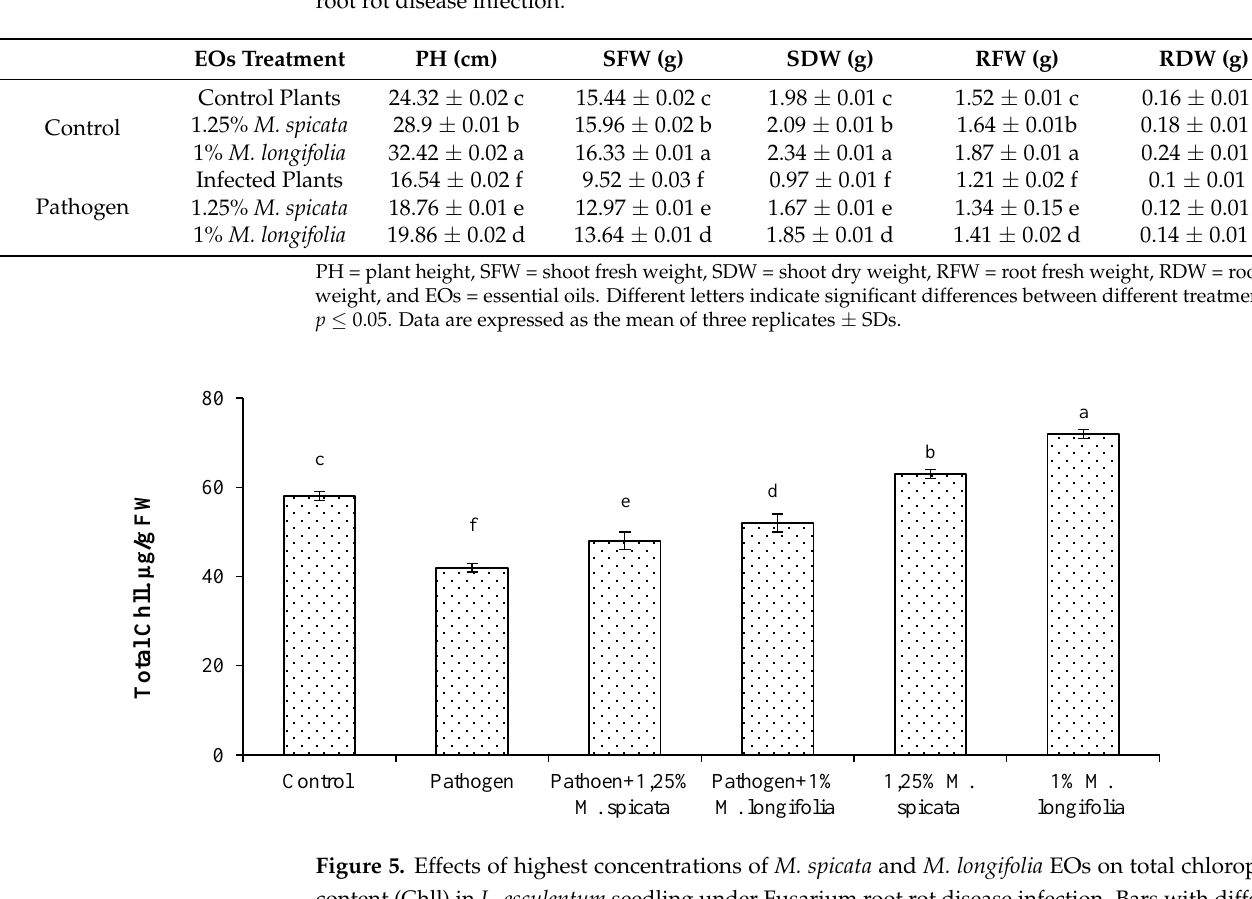
Figure 6. Effects of highest concentrations of M. spicata and M. longifolia EOs on electrical leakage percentage (EL%) in L. esculentum seedling leaves under Fusarium root rot disease conditions. Bars with different letters indicate significant differences between treatments at p ≤ 0.05. Data are expressed as the mea n of three replicates ± SDs.